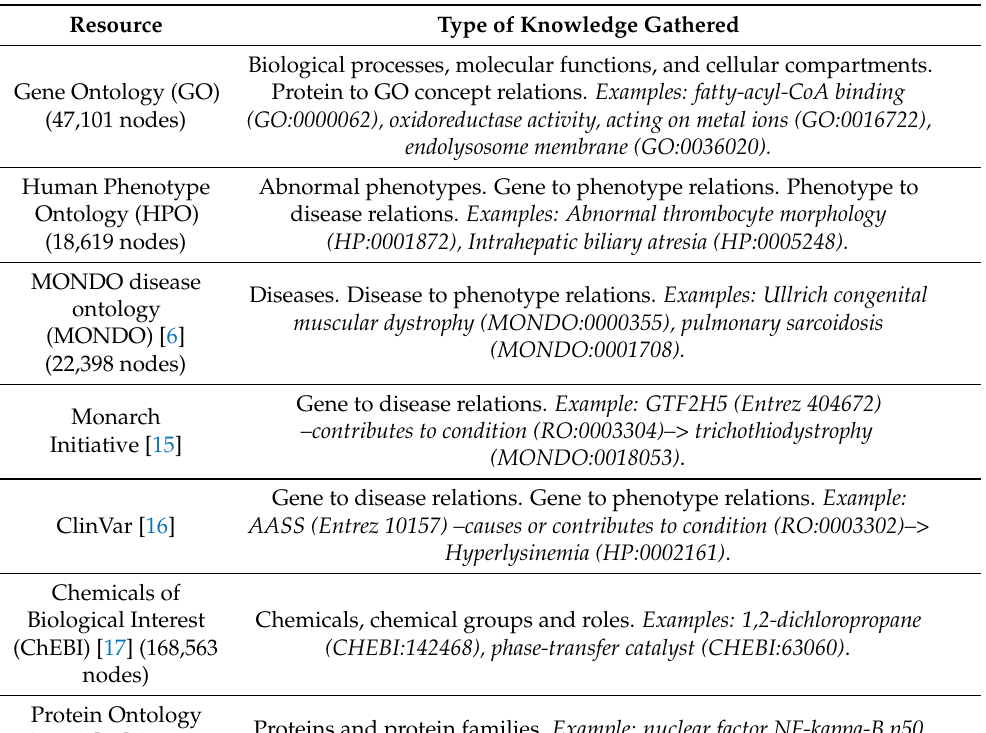
Table 1. Public resources utilized for the creation of the KG. The node counts reflect the subset of concepts from each resource that were included in the